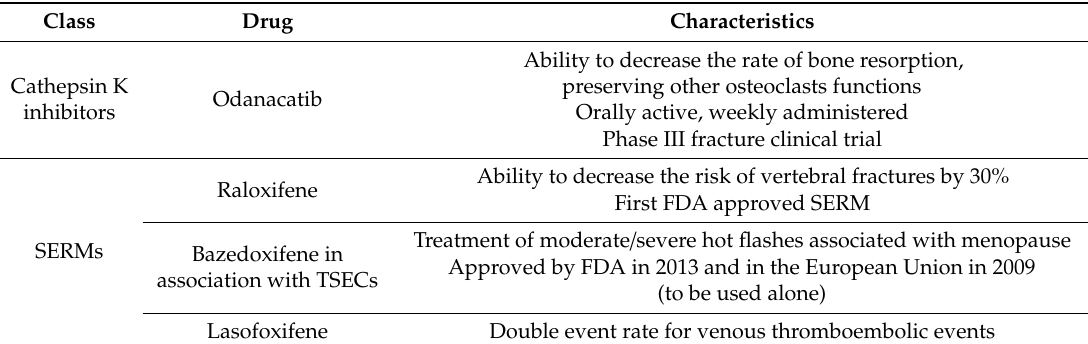
Table6. Characteristicsofnewerantiresoprtivesandselectiveestrogenreceptormodulators(SERMs)[28].